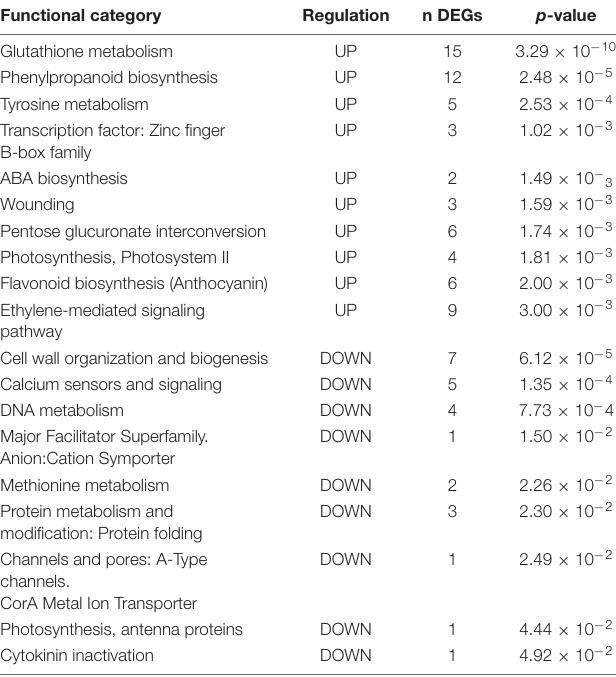
TABLE 3 | Functional enrichment in Group II. DEGs up- and down-regulated by the two pathogens and Vintec R (cid:13) (IVPP). Functional